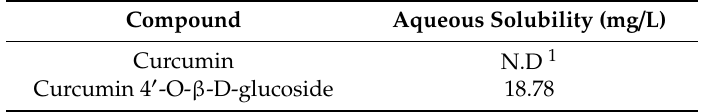
Table 2. Aqueous solubility of curcumin and curcumin 4’-O- β -D-glucoside.